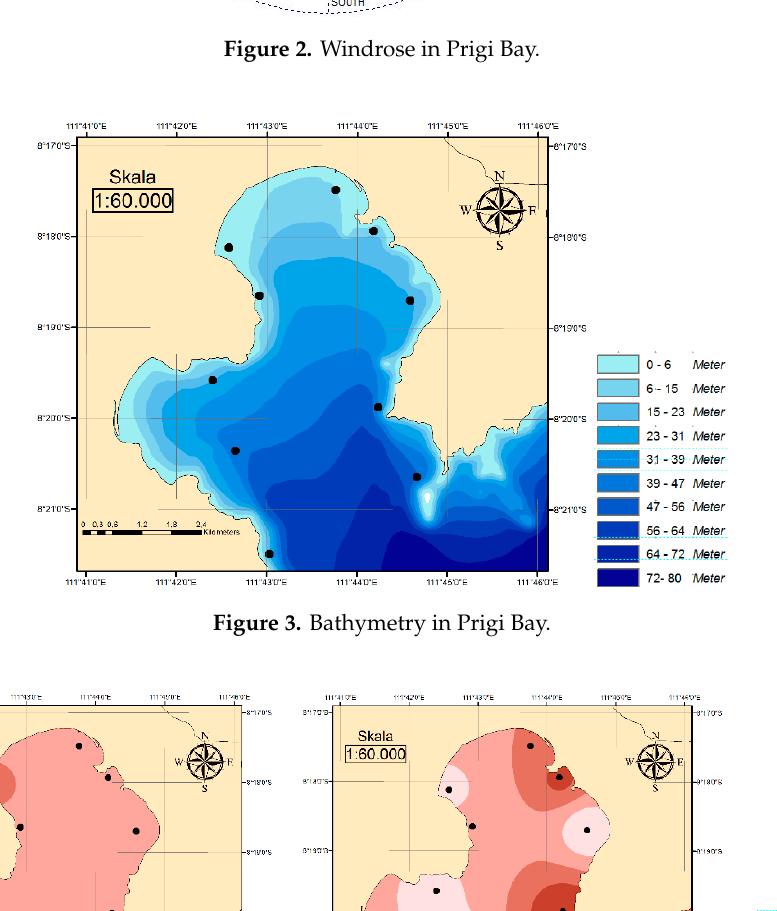
Figure 2. Windrose in Prigi Bay.